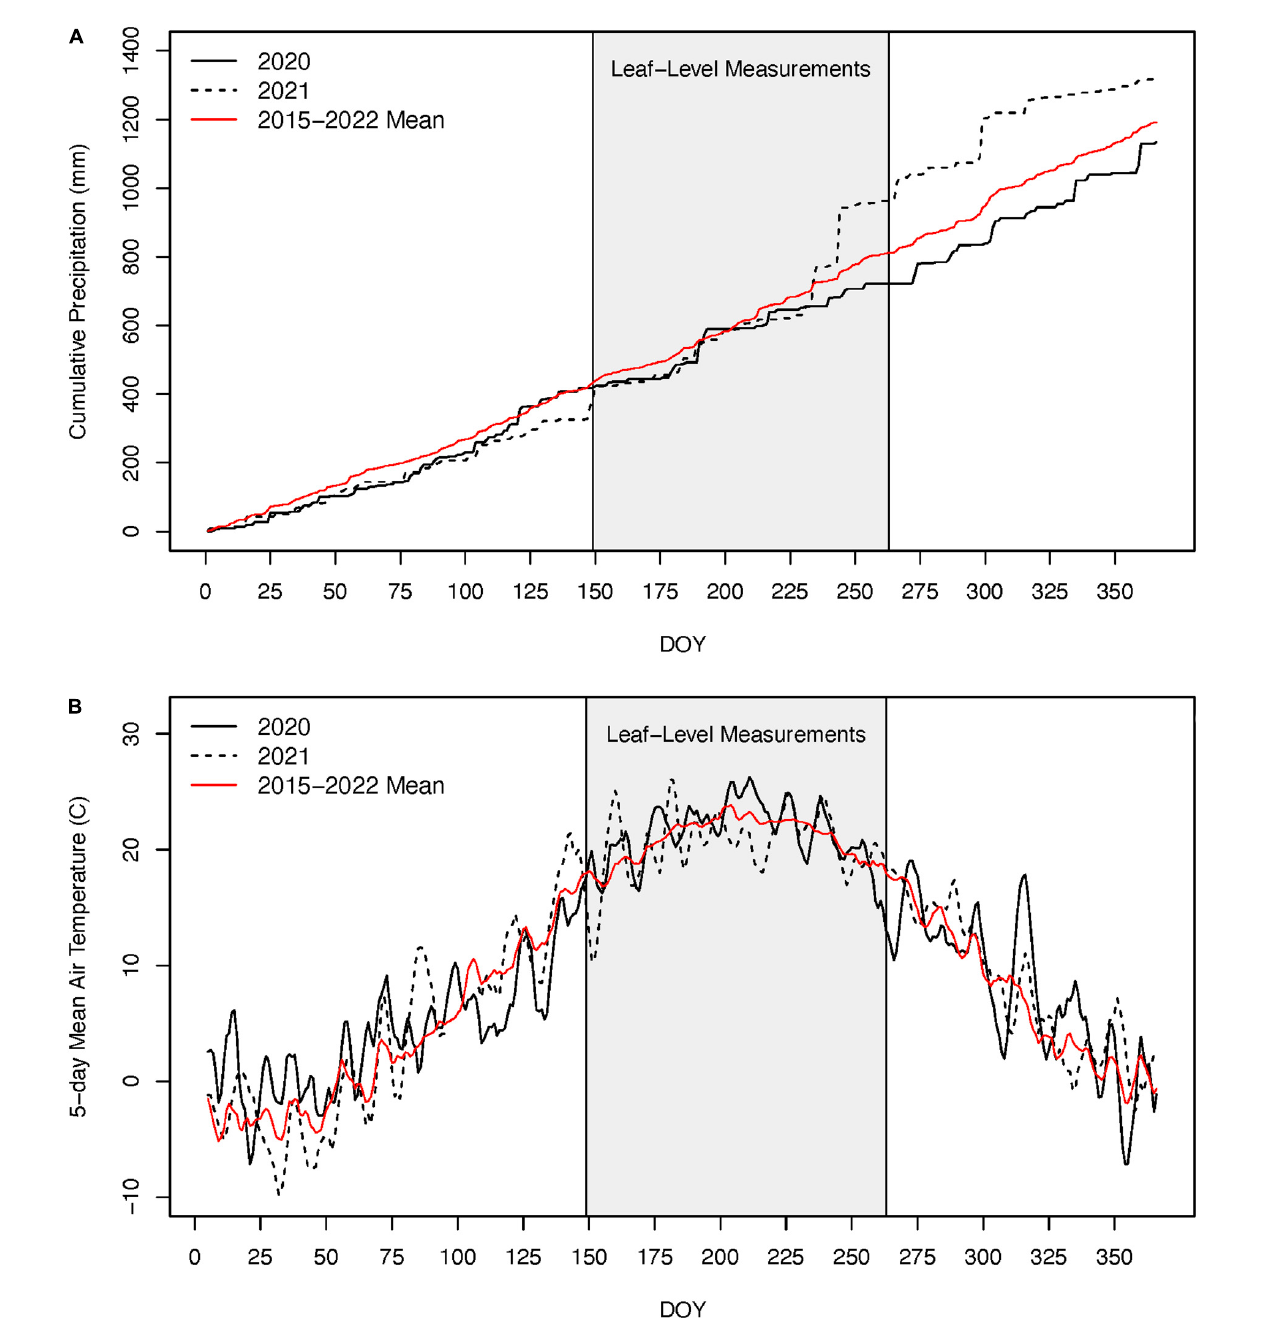
FIGURE4 Cumulative precipitation (A) and 5-day running mean daily air temperatures (B) for 2020, 2021, and the 2015–2022 mean (i.e., period of time with available records for Black Rock Forest) (A) . The gray box indicates the period during which we made leaf-level physiological measurements. Note, the large precipitation events in 2021 occurred after our August (late growing season) measurements and after nearly all radial tree growth